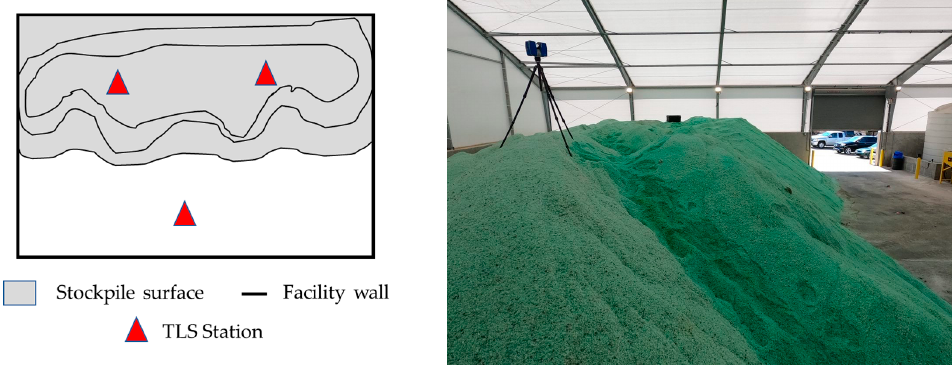
Figure 26. Illustration of TLS acquisition stations in the US-231 facility: schematic top view ( left ); TLS setup on top of the stockpile ( right ).